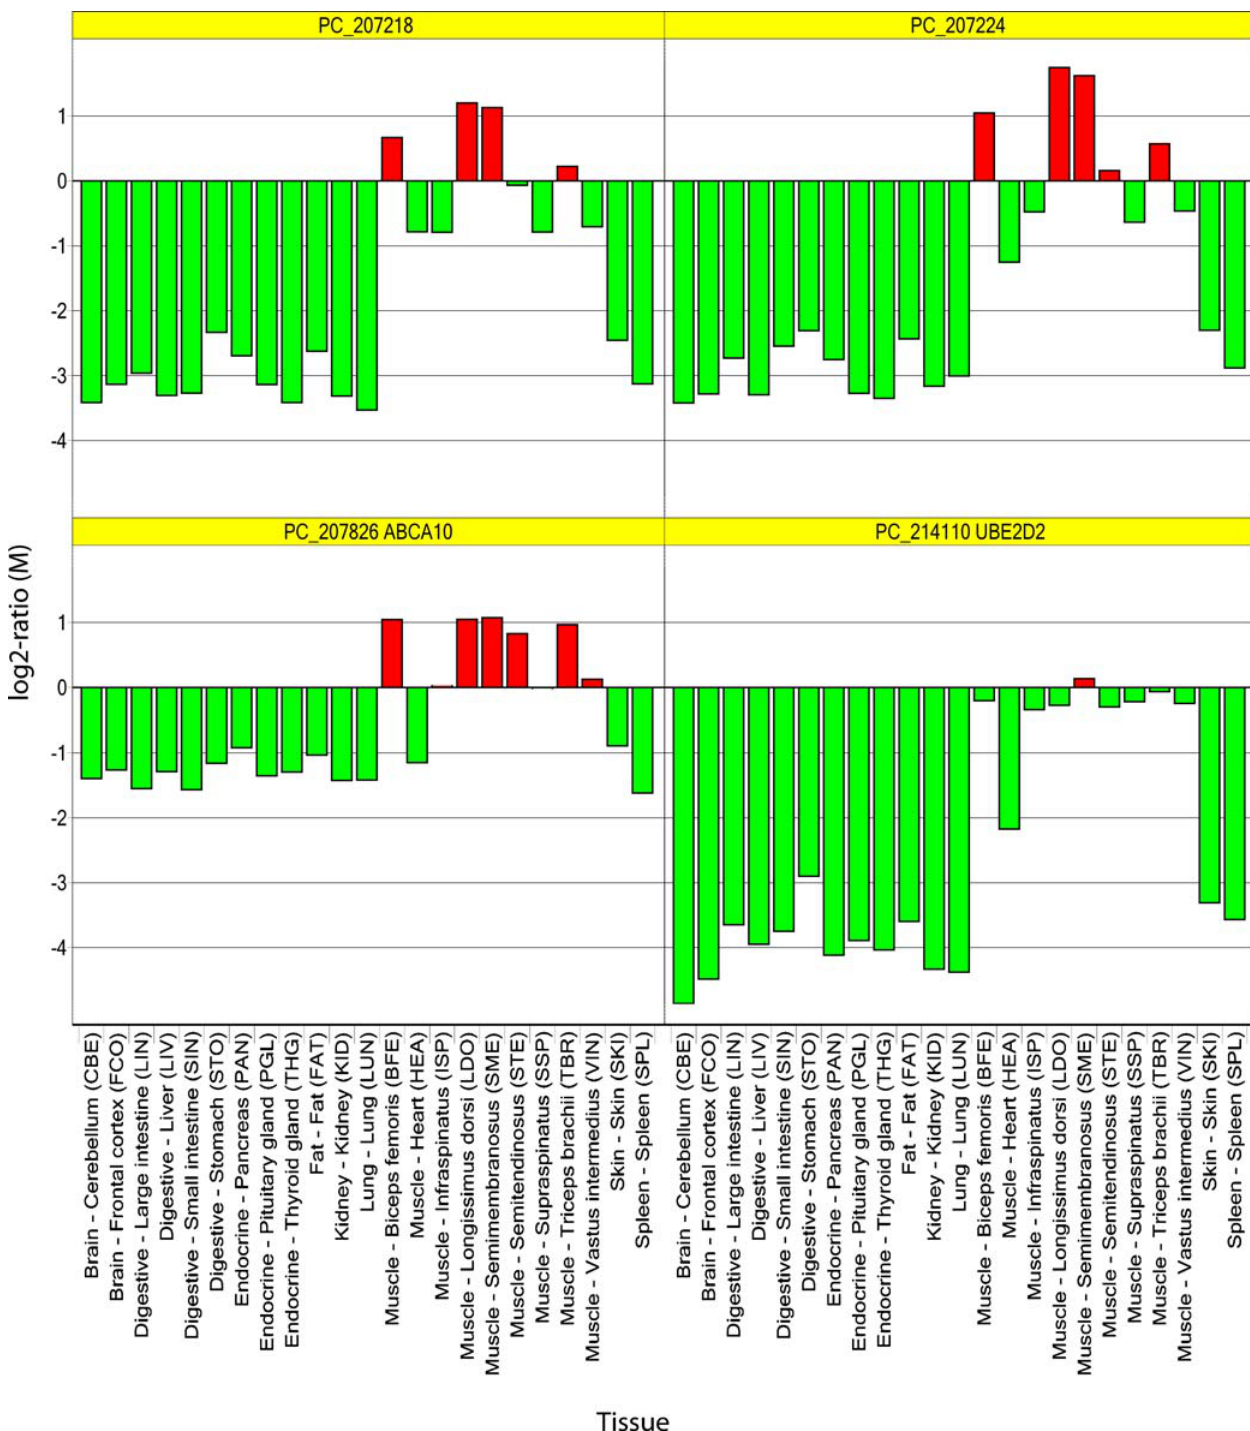
Figure 4. Expression profiles of uncharacterized genes and co-expressed genes with known function. Each histogram represents the expression profiles of a single cDNA across all 23 tissues for two uncharacterized protein coding genes (PC_207218, PC_207224) and four co-expressed genes with known function (PC_207826: ABCA10, PC_214110: UBE2D2). Each bar represents the gene expression ratio (M) between the tissue sample and the common reference sample on the logarithmic scale. M values below zero, indicating lower gene expression level, are shown by green bars. M values above zero, indicating higher expression, are shown by red bars.